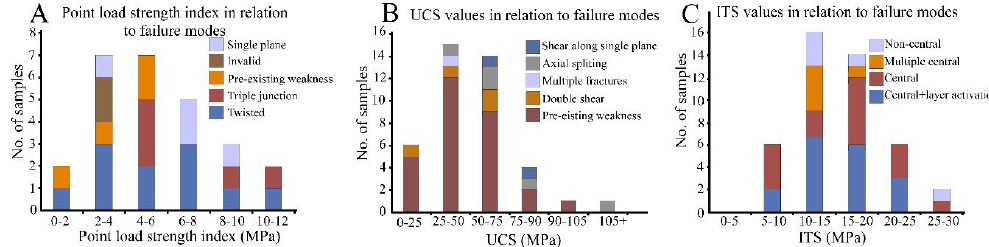
Figure 7. ( A ) Bar diagram showing the different ranges of point load (MPa) values in relation to the failure modes. ( B ) Bar diagram showing the different ranges of UCS (MPa) values in relation to the failure modes. ( C ) Bar diagram showing the different ranges of ITS (MPa) values in relation to the failure modes.